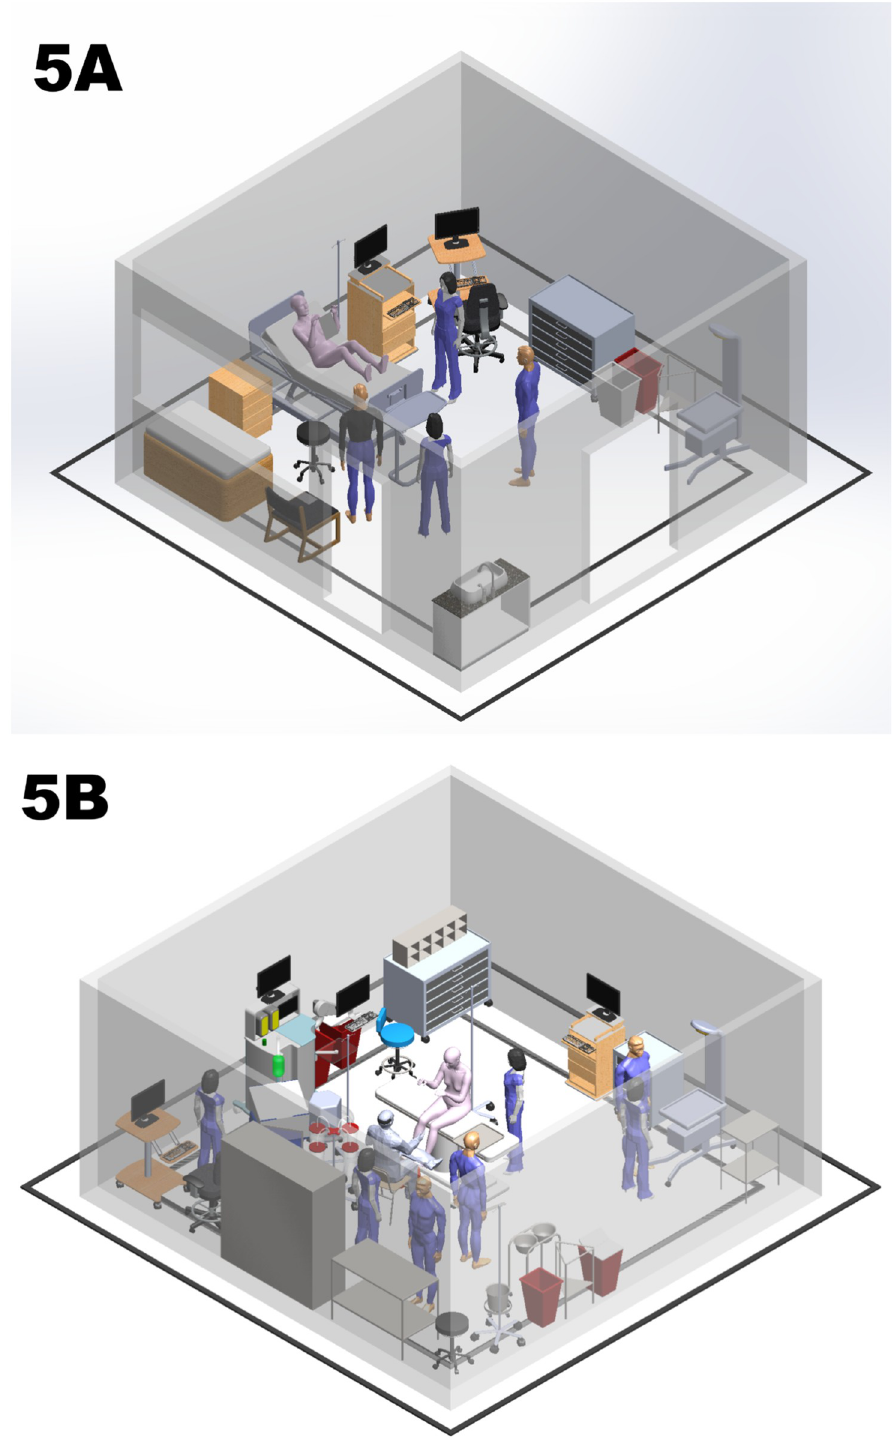
Fig 5. Scale renderings of labor room (5A) and operating room (5B). Room size, common equipment and approximate number of providers shown to scale. Flat black squares represent hospitals with lowest and highest mean room square footage. Upright walls represent mean square footage of all